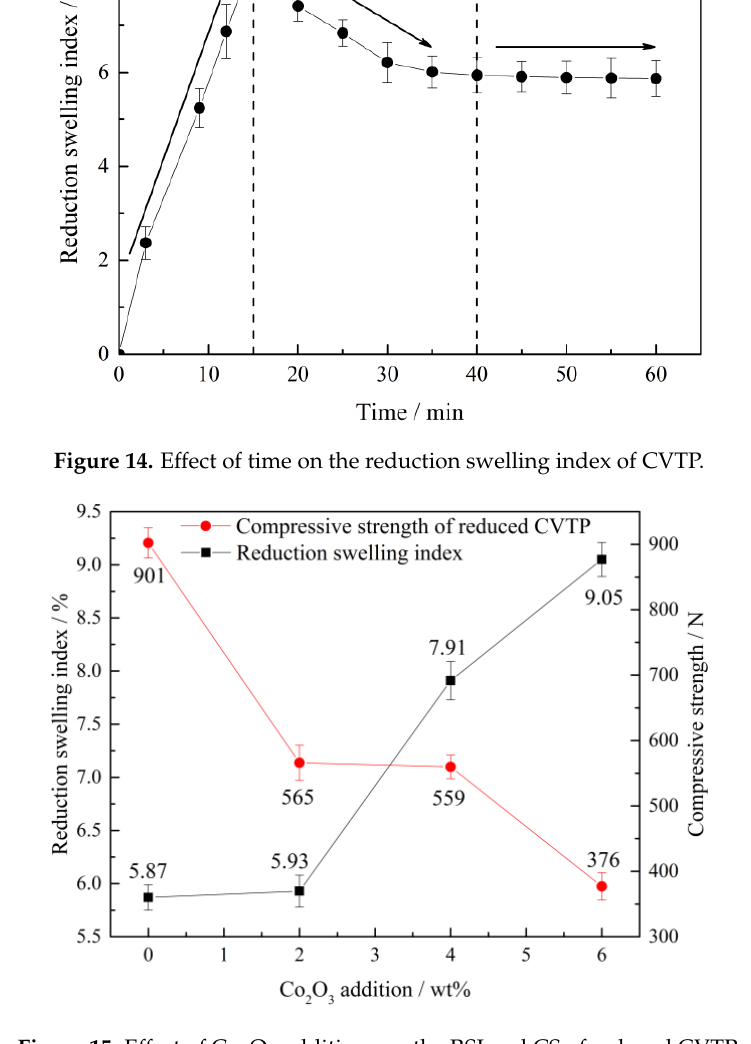
Figure 15. Effect of Co 2 O 3 additions on the RSI and CS of reduced CVTP.